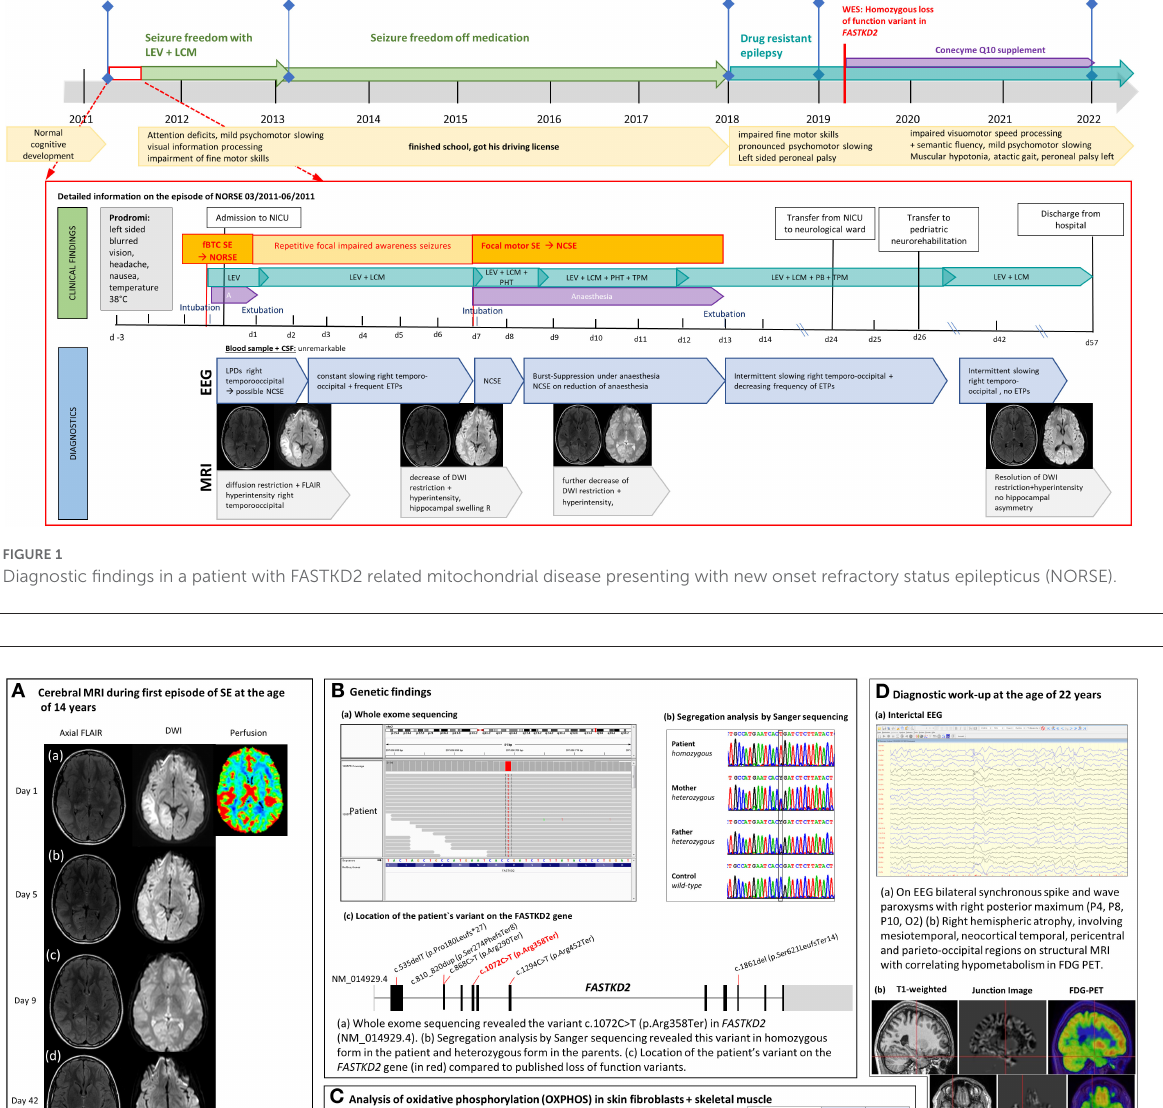
On day 7, the patient developed another focal motor SE with the impairment of consciousness and left-sided clonic, resistant to benzodiazepines and IV ASMs (LEV, LCM, phenytoin, and PHT). EEG showed lateralized periodic epileptiform discharges over the right hemisphere, with spatiotemporal